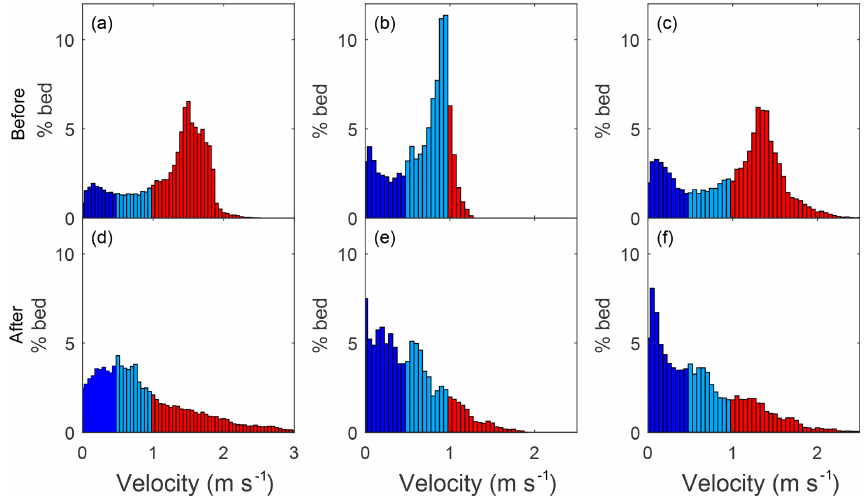
Figure 4. Velocity distributions at bankfull flow at Sites 1 (a, d) , 2 (b, e) , and 3 (c, f) before (a–c) and after (d–f) the addition of large wood (LW). The colors correspond to thresholds of velocity relevant to the ability of juvenile coho salmon to maintain position in the stream: dark blue means v<v crit where v crit = 0 . 5ms − 1 , light blue means v crit <v<v burst where v burst = 1ms − 1 , and red means v>v burst